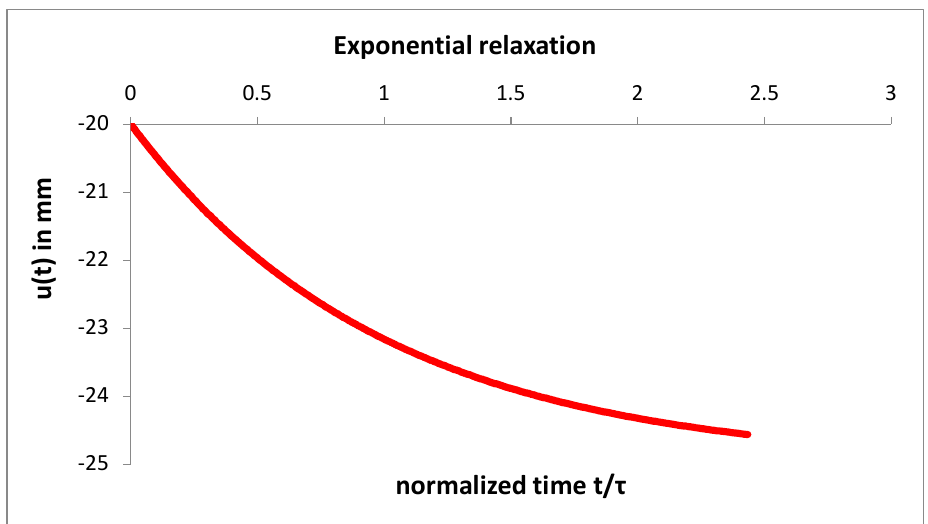
Figure 1. Example of exponential relaxation (see Equation (1)) with S = 5 mm, u ∞ = −25 mm and τ = 300 days.